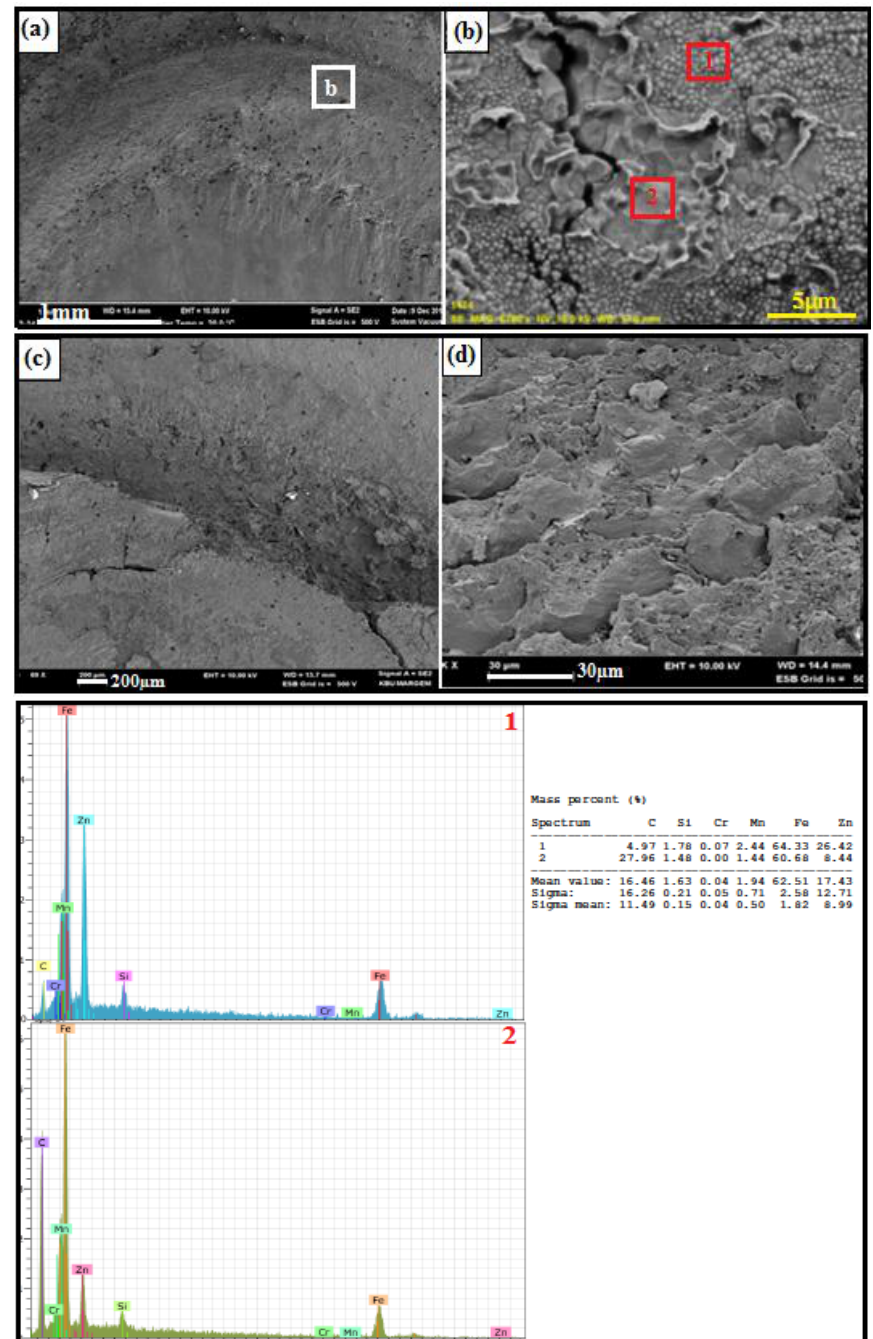
Figure 7. Failure modes: ( a ) IF mode. ( b ) Magnification view of IF mode (1 and 2 are point of EDS analysis). ( c ) PIF mode. ( d ) Magnification of PIF mode.